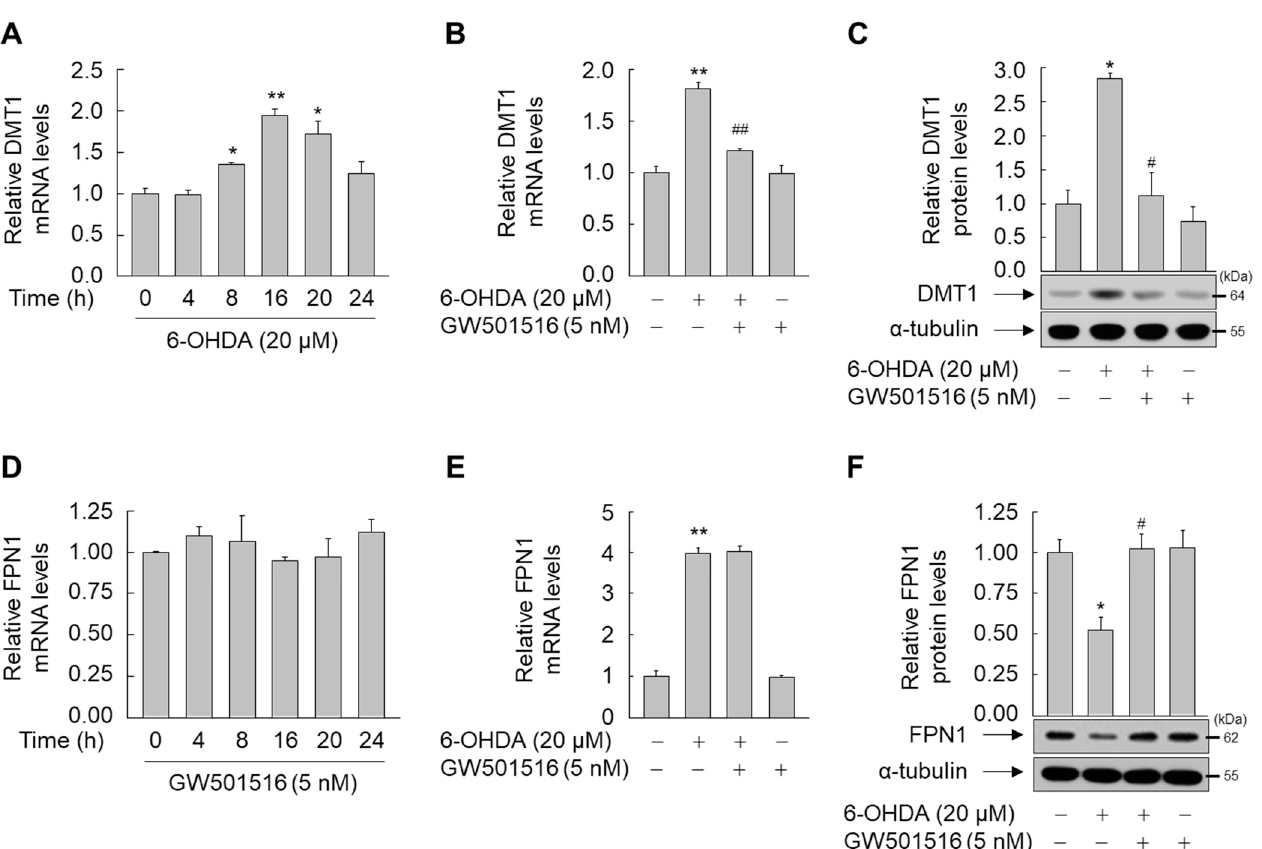
Figure 4. GW501516 activation of PPAR δ regulates 6-OHDA-triggered expression of level of DMT1 and FPN1 protein, and DMT1 mRNA, but not FPN1 mRNA. ( A ) Cells were treated with 6-OHDA for the indicated durations. ( B , C ) Cells pretreated with DMSO or GW501516 for 8 h were incubated with or without 6-ODHA for 16 h. ( D ) Cells were treated with GW501516 for the indicated durations. ( E , F ) Cells pretreated with DMSO or GW501516 for 8 h were incubated with or without 6-ODHA for 16 h. Total RNA and protein were extracted, and mRNA and protein levels were analyzed by real-time PCR ( A , B , D , E ) and Western blot ( C , F ), respectively. RPS18 and α -tubulin were used as internal controls for real-time PCR and Western blot, respectively. Results are expressed as means ± SE ( n = 3). An image analyzer was used to quantify band intensity of Western blot, and the ratio of protein to α -tubulin is indicated above each lane. * p < 0.05, ** p < 0.01 relative to the untreated group; # p < 0.05, ## p < 0.01 relative to the 6-OHDA-treated group.